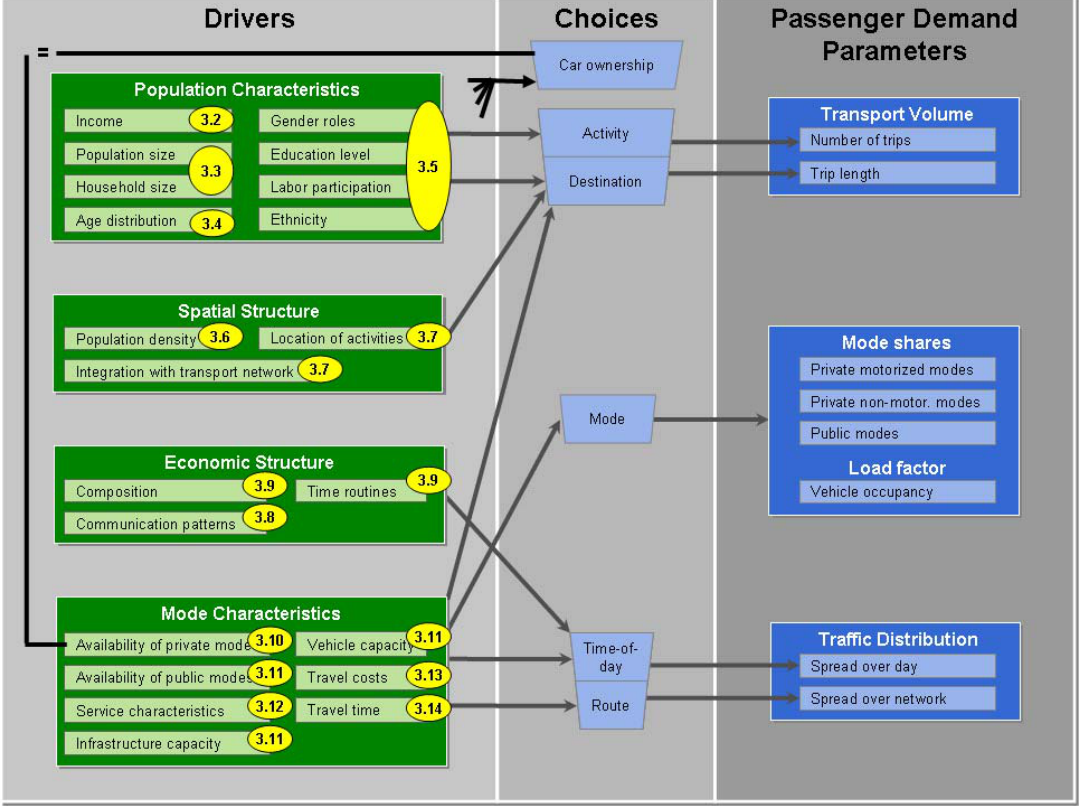
Figure 1. Drivers of passenger transport